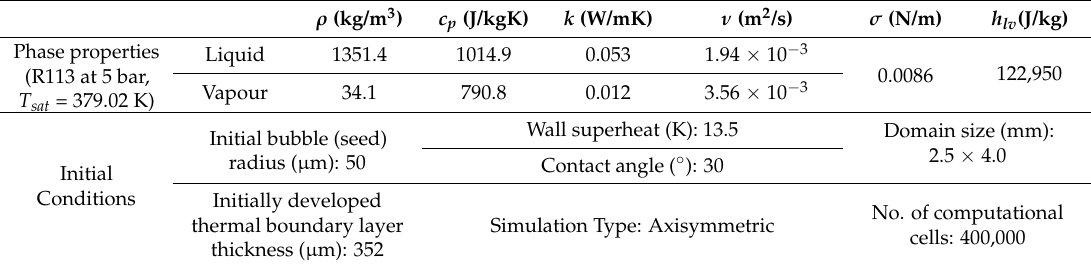
Table A4. Fluid properties and initial conditions (base case for R113, at 5